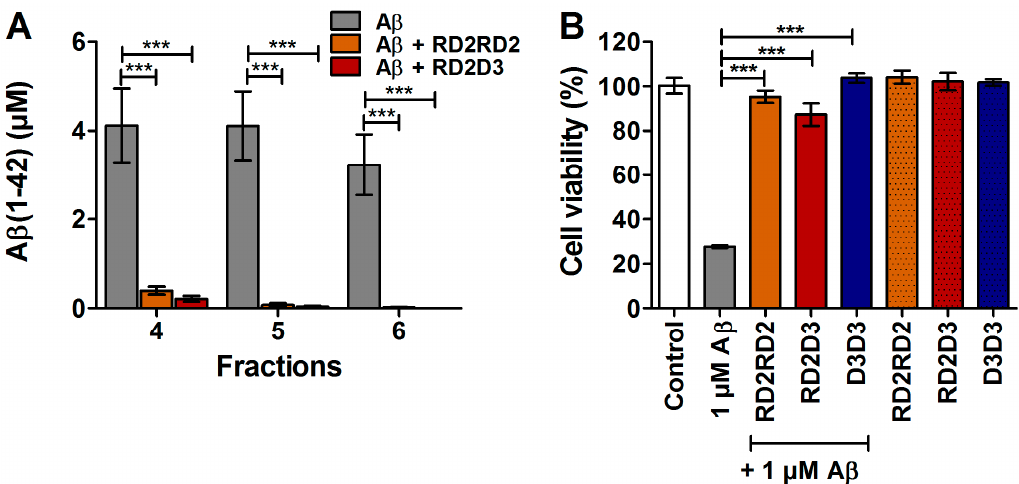
Figure 1. RD2RD2 and RD2D3 eliminated toxic amyloid β protein (A β ) oligomers and reduced A β induced cell toxicity. Potency of RD2RD2 and RD2D3 to reduce toxic A β oligomers was demonstrated in vitro by the QIAD assay ( A ). Both compounds were able to reduce the toxic A β oligomers present in fractions 4–6. Cell viability was assessed by MTT (3-(4,5-dimethylthiazol-2-yl)-2,5-diphenyl-tetrazolium bromide) after incubation of PC-12 cells ( B ) with 1 µ M A β (1–42) co-incubated with 1 µ M RD2RD2 (orange), 1 µ M RD2D3 (red), or 1 µ M D3D3 (blue). All compounds significantly increase the cell viability after co-incubation with A β (1–42), without having negative impact on cell viability when incubated alone (patterned bars). Data is represented as mean ± SD (standard deviation), one-way ANOVA (analysis of variance) with Fisher post hoc analysis, *** p ≤ 0.001.